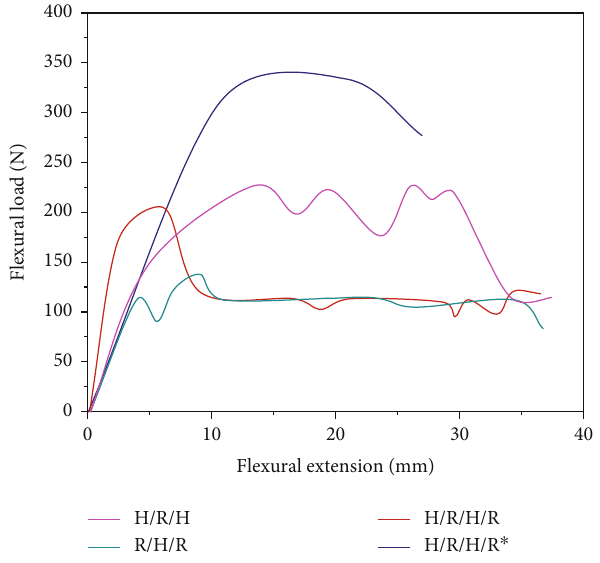
Figure 5: For hybrid composites, the fl exural load – extension